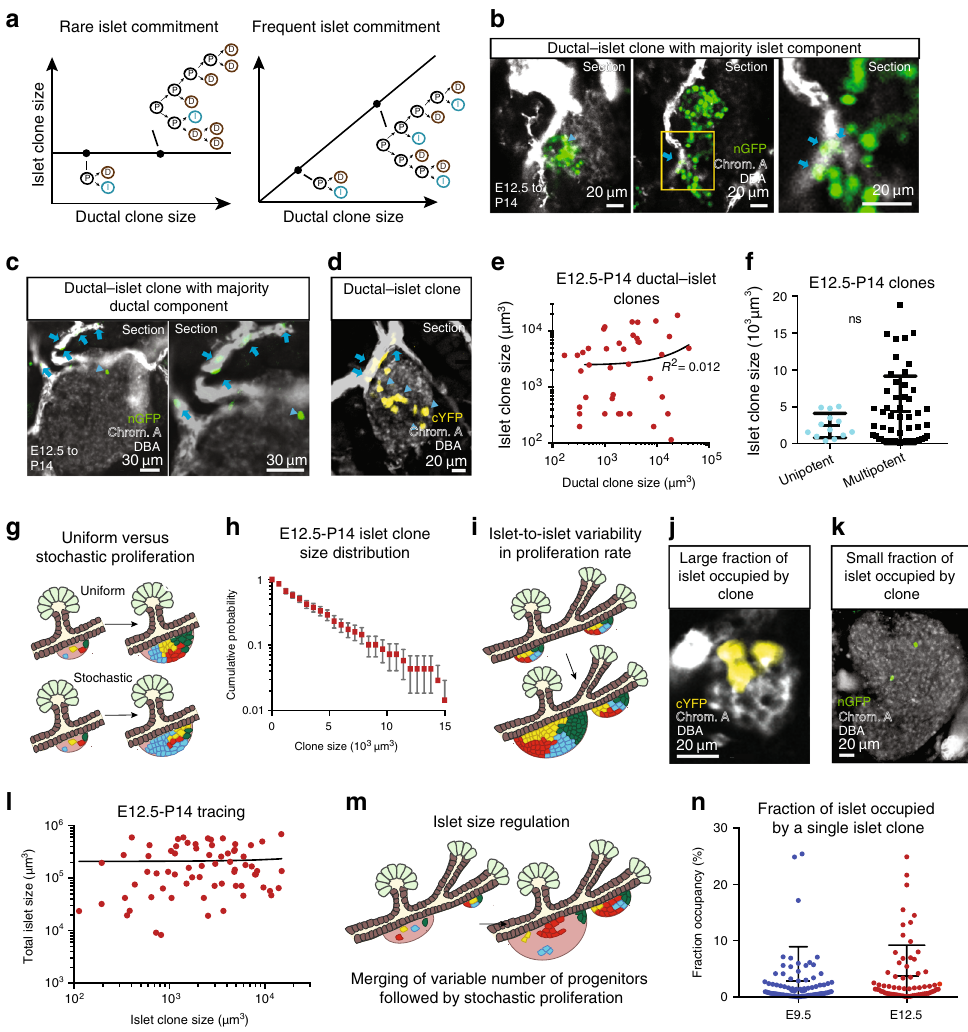
Fig. 2 Coalescence and stochastic proliferation of islet progenitors underlies islet size heterogeneity. a (Left) Schematic depicting speci fi cation of islet progenitors from bipotent ductal – islet progenitors: If islet progenitor production were a rare event, islet clone size would be independent of ductal clone size. If the rate were high, islet clone size would scale in approximate proportion to ductal clone size. Representative images from 3 experiments based on >15 recorded images each showing examples of ductal – islet clones with islet representation being b majority, c minority and d approximately equal. b , c show snapshots from different Z-sections. Arrows indicate ductal cells, arrowheads indicate islet cells. DBA shown white, Chromogranin A in grey. e Dot plot of ductal to islet size within individual clones showing weak correlation ( R 2 = 0.012). f Plot of islet size of unipotent (islet-only) and multipotent clones showing no statistically signi fi cant difference in average size ( n = 13 unipotent and n = 53 multipotent clones from N = 3 mice, P = 0.76, two-tailed Mann – Whitney test). Error bars show average ± SD. g Schematic depicting possible modes of islet expansion: (top) endocrine progenitors expand uniformly within islets; (bottom) progenitors have variable proliferative capacity. h Cumulative distribution of islet clone sizes shows exponential-like dependence ( “ Methods ” , n = 69 clones from N = 3 mice). Error bars show average ± SD. i Schematic depicting hypothesis that islet size heterogeneity is associated with local islet-to-islet variability in proliferative activity of constituent progenitors. Representative images (based on >10 recorded images each) from 3 experiments showing variable labelling fraction within islets with j large clone fraction and k small clone fraction. DBA shown white, Chromogranin A in grey. l Dot plot showing that there is no correlation between islet clone size and total size of host islet ( R 2 = 0.001). m Summary schematic of islet growth whereby the fi nal size of islets is dictated by degree of polyclonality arising from coalescence of islet progenitors combined with stochastic proliferation. Smaller islets are, on average, composed of a smaller number of founding progenitors that merge. n Fraction of islets occupied by individual islet clones traced from E9.5 to P14 and E12.5 to P14 ( n = 93 clones from N = 5 mice at E9.5 and n = 69 clones from N = 3 mice at E12.5). Error bars show average ± SD. Source data provided as Source Data fi